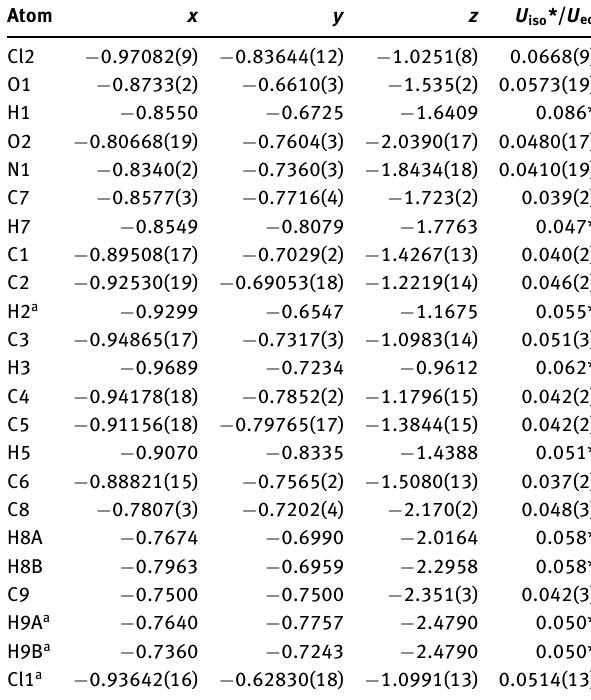
Table 2: Fractional atomic coordinates and isotropic or